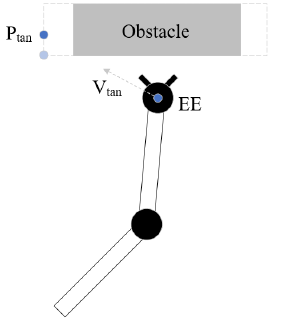
Figure 2. Schematic diagram of tangential